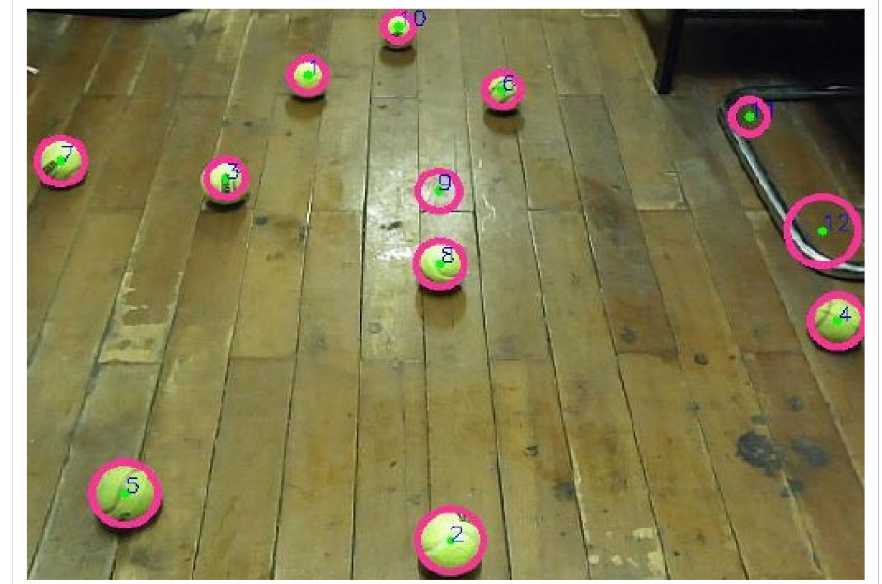
Figure 6. Hoff circle gradient method for detecting tennis